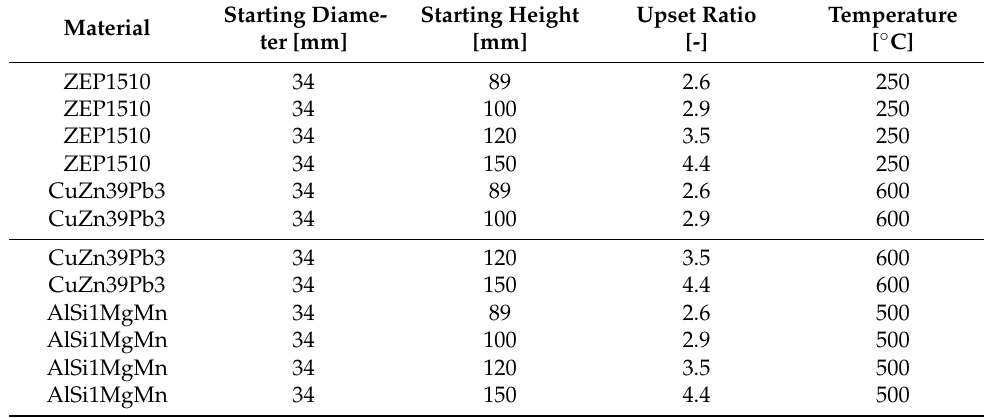
Table 1. Sample dimensions for the tests to determine the upset ratio.